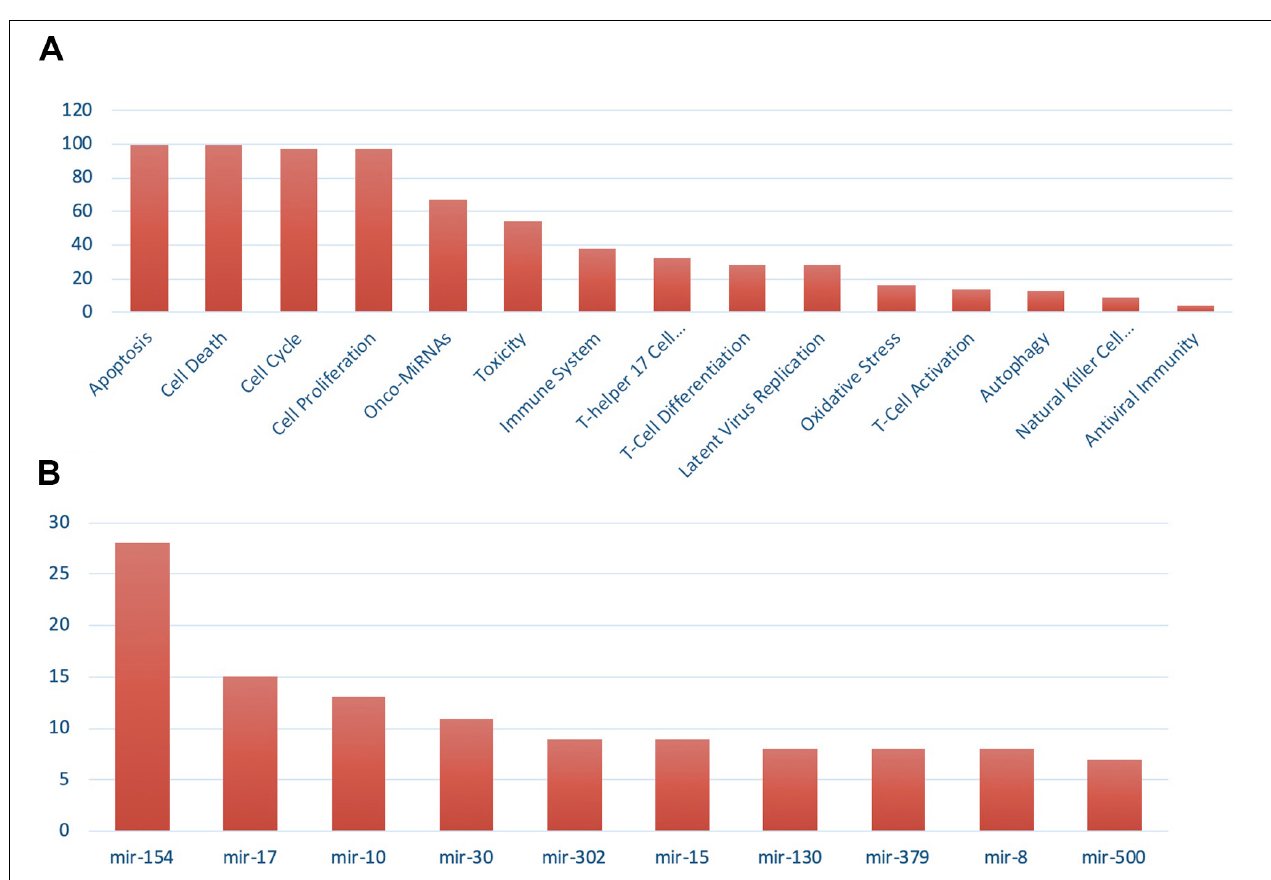
FIGURE 3 | Gene set enrichment analysis showing (A) functional analysis of miRNAs and (B) miRNA family